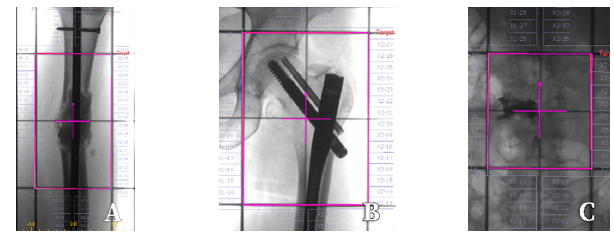
Figure 3. Simulation fields (pink rectangle) for irradiation of painful bone metastases with photon external beams. ( A , B )—metastases to the femur after surgical stabilization, ( C )—metastasis to megavoltage photon external beams. ( A ), ( B )—metastases to the femur after surgical stabilization, the vertebral body after percutaneous ( C )—metastasis to the vertebral body after percutaneous vertebroplasty.